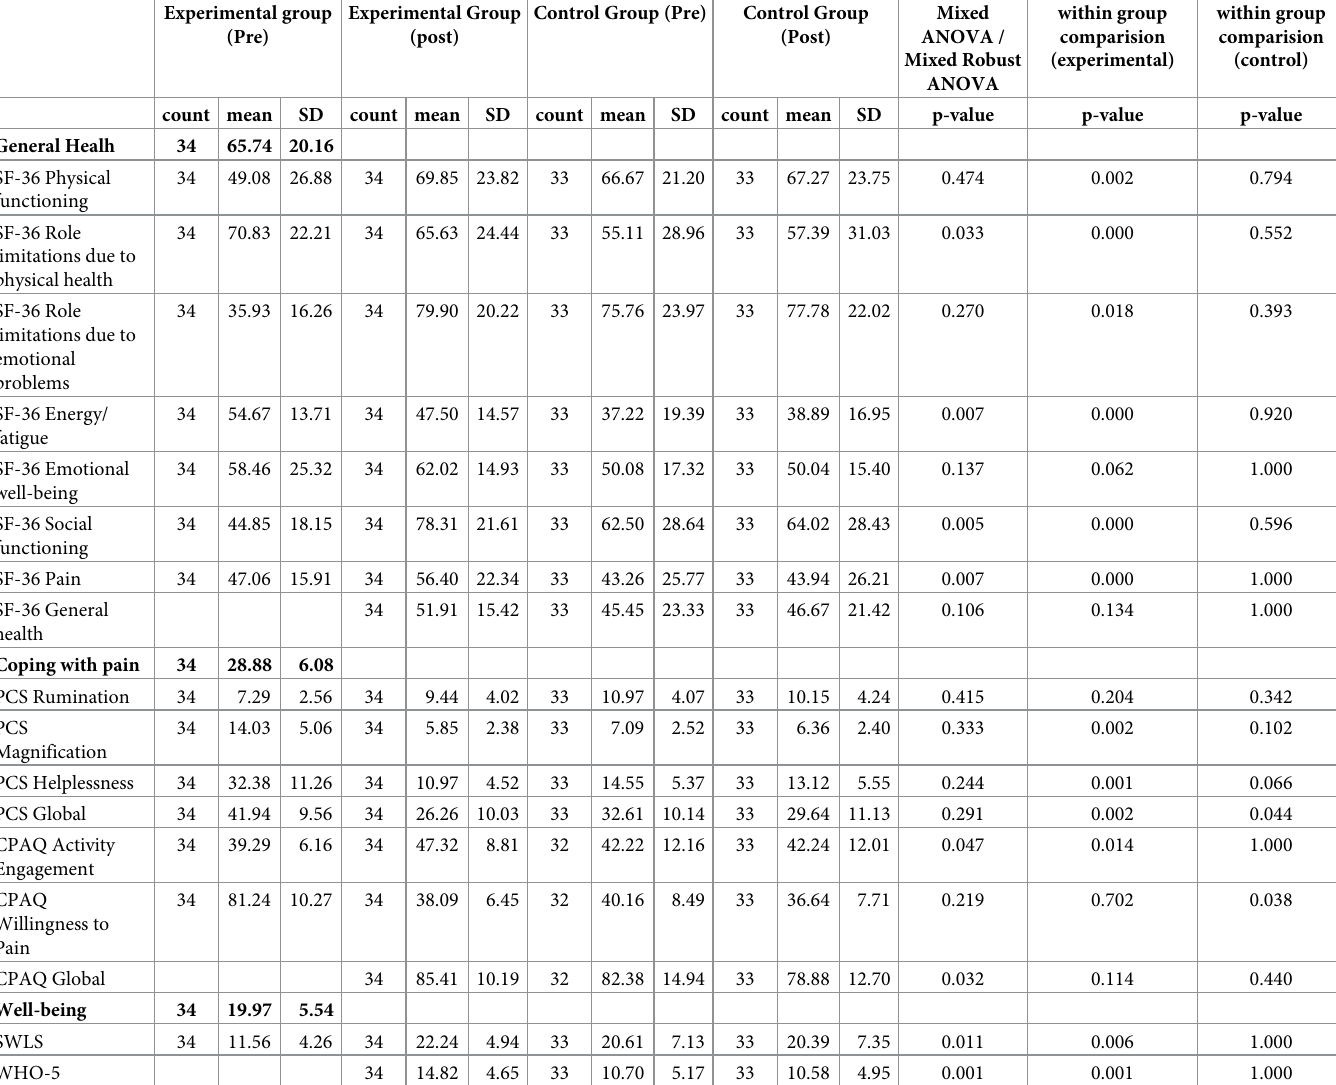
Table 2. The results of the assessment of general health, coping with pain and well-being. Experimental group